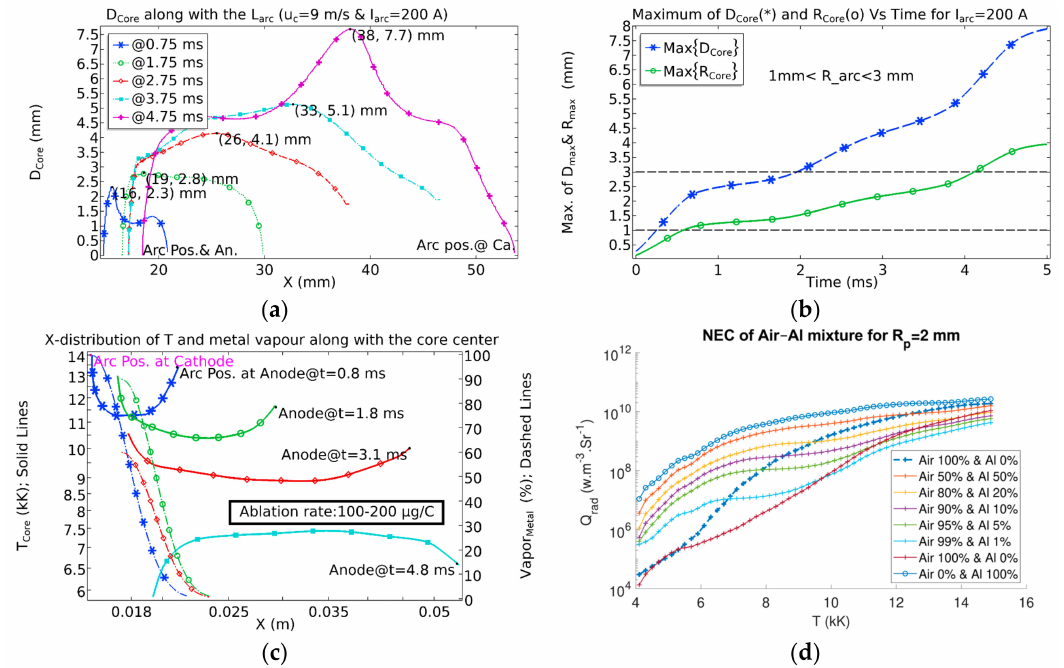
Figure 2. ( a ) Variable core diameter along with its length, ( b ) Maximum of core radius, ( c ) Distribution of T and metal vapor along the core center, and ( d ) net emission coe ffi cient NEC air-Al in arc chamber for 200 A peak